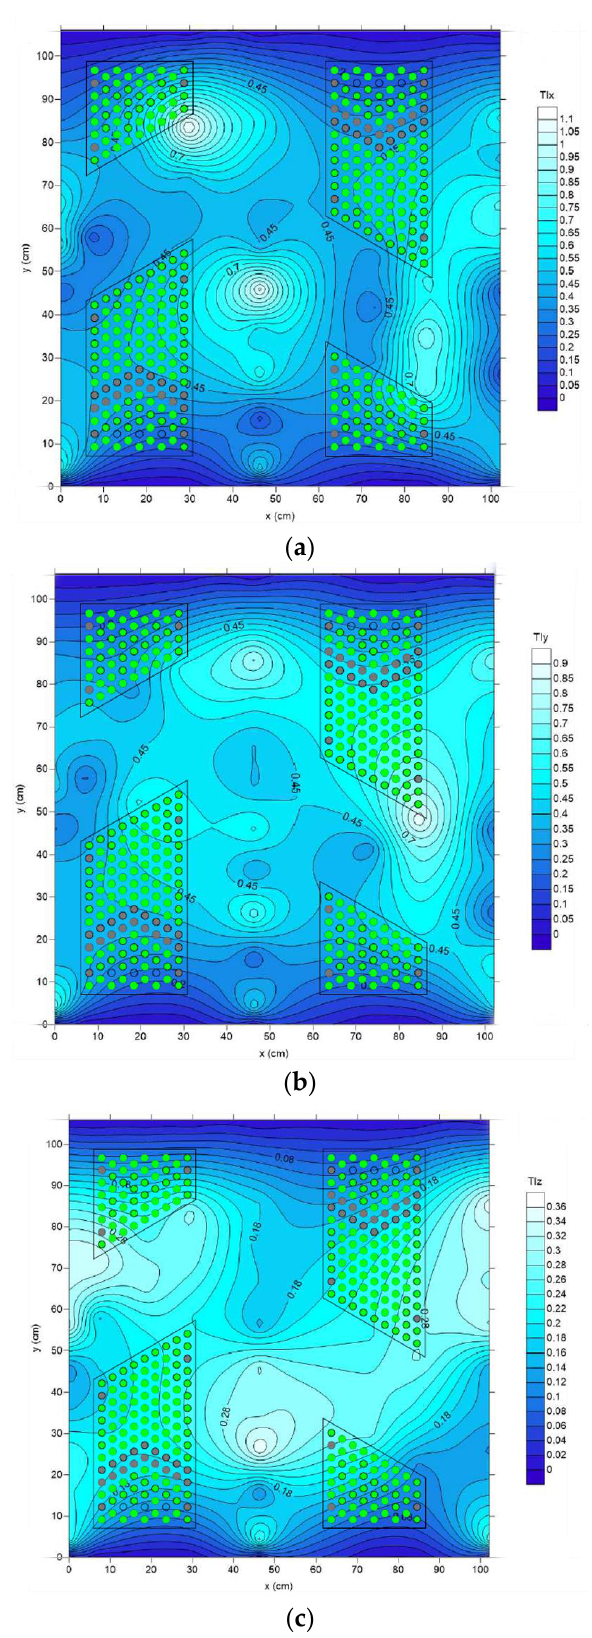
Figure 10. Distribution of turbulence intensities in three directions around brush blocks for d/h = 0.92 at z/d = 0.60 for Q = 0.187 m 3 /s: ( a ) TI x , ( b ) TI y , and ( c ) TI z .